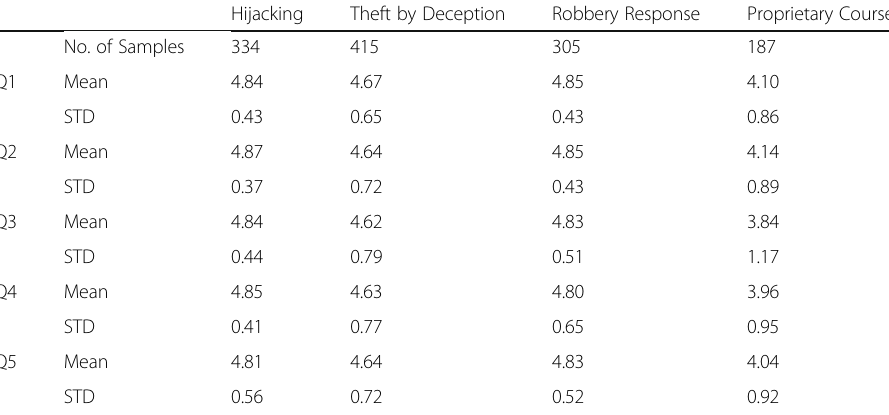
Table 1 The mean and standard deviation of the trainees rating of the five questions in the survey for four courses Hijacking Theft by